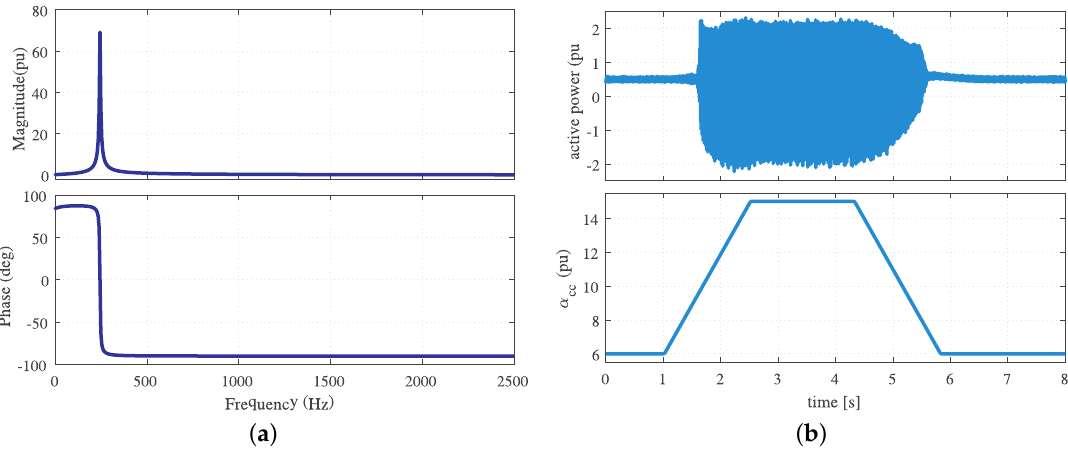
Figure 9. ( a ) Frequency response of the connection-grid impedance, Z grid ; ( b ) active-power output of the converter with a resonance grid connection and R v = R f , L v = L f during a change in the current-controller bandwidth, α cc .